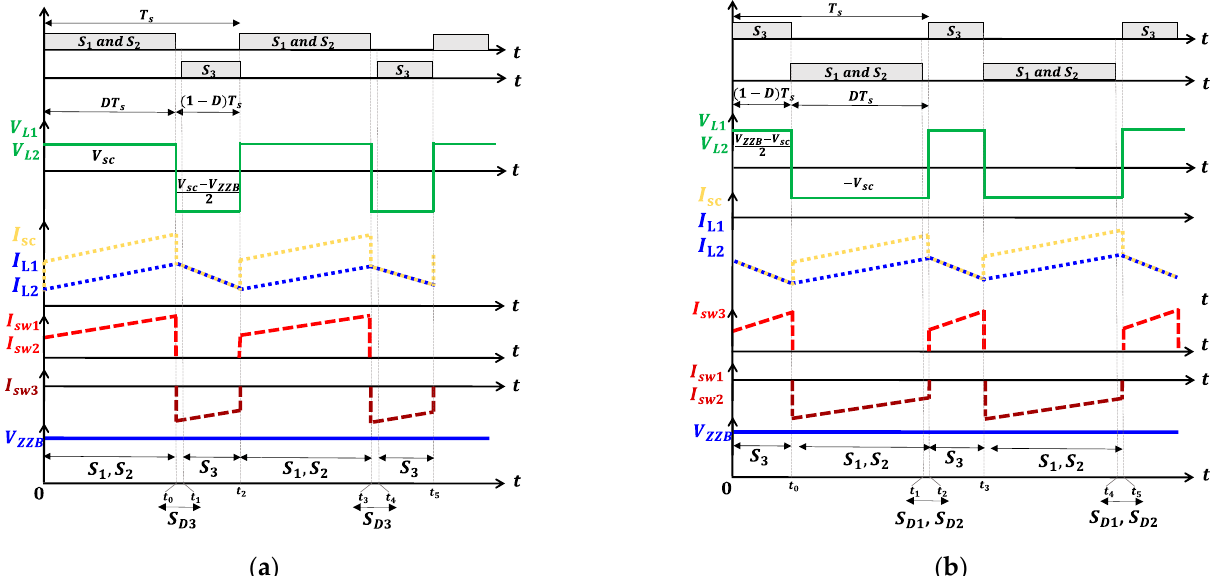
Figure 4. The implemented PWM method and the corresponding voltage and current waveforms for various components: ( a ) during the discharging of the SC; ( b ) during the charging of SC. [49].